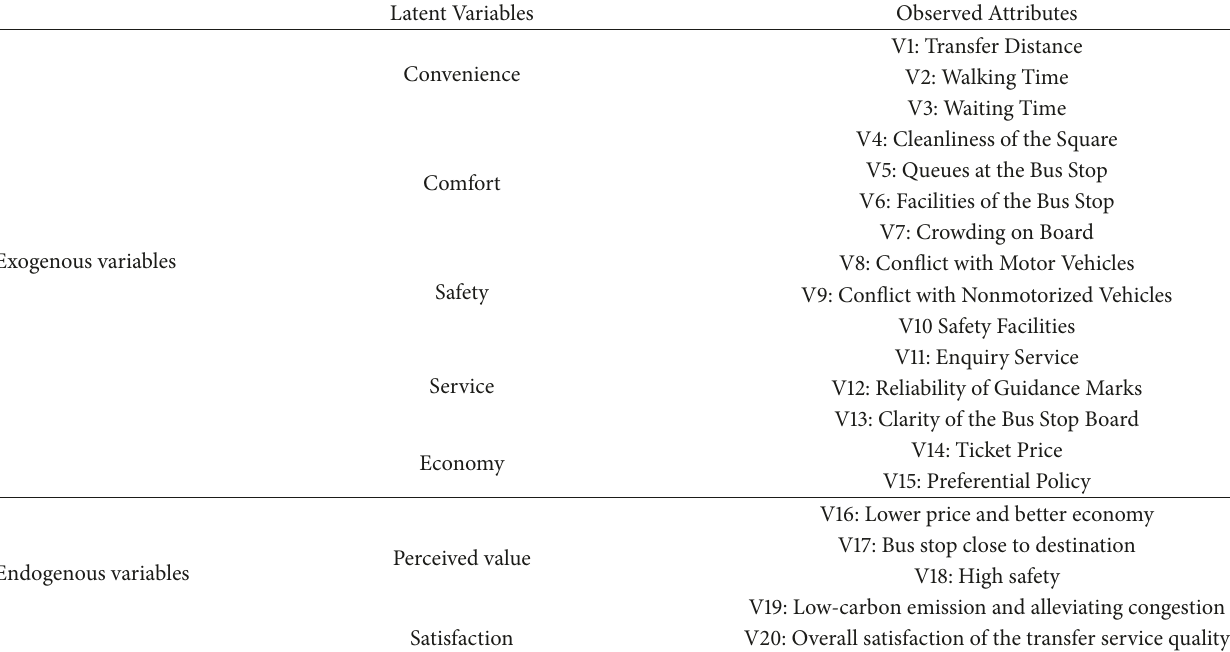
Table 1: The latent variables and observed attributes of the structure equation